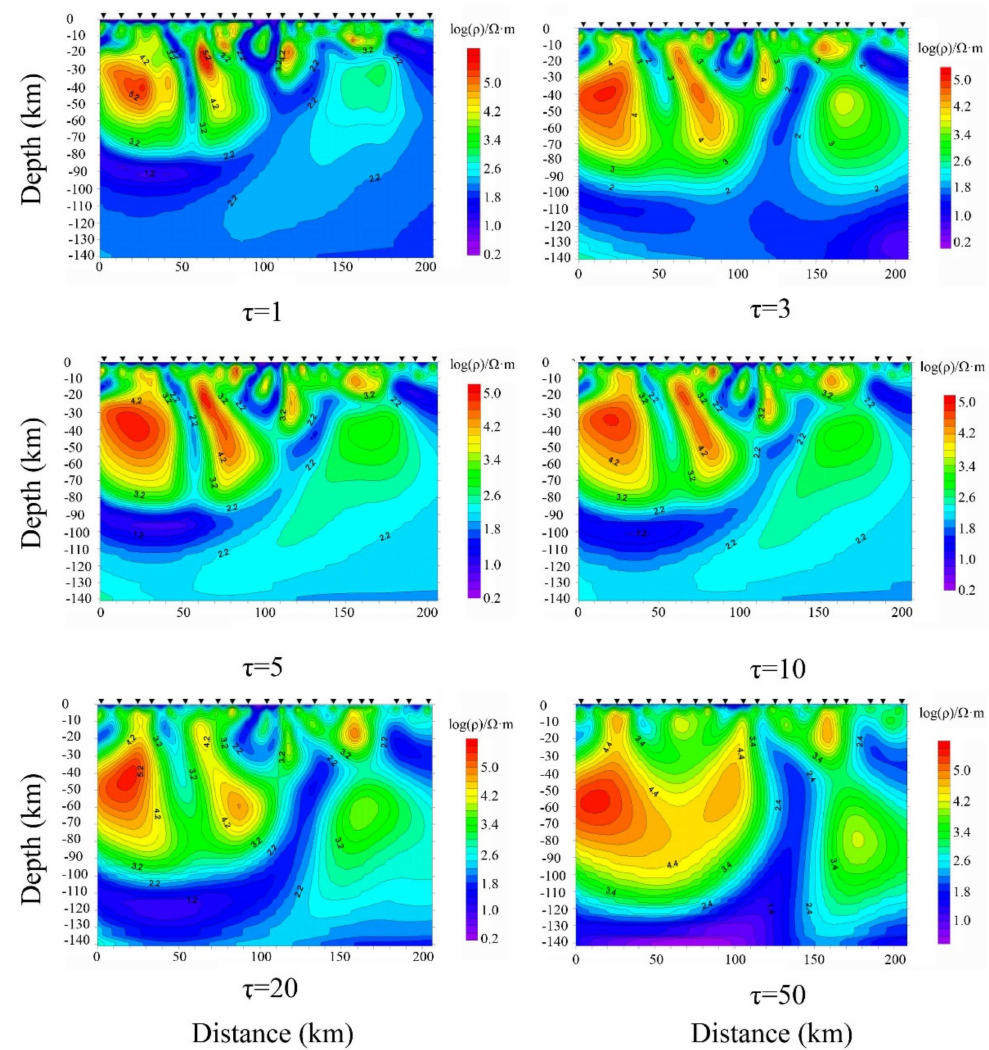
Figure 6. 2D inversion results of NLCG in L300 TM mode under different the regularization parameter ( τ )